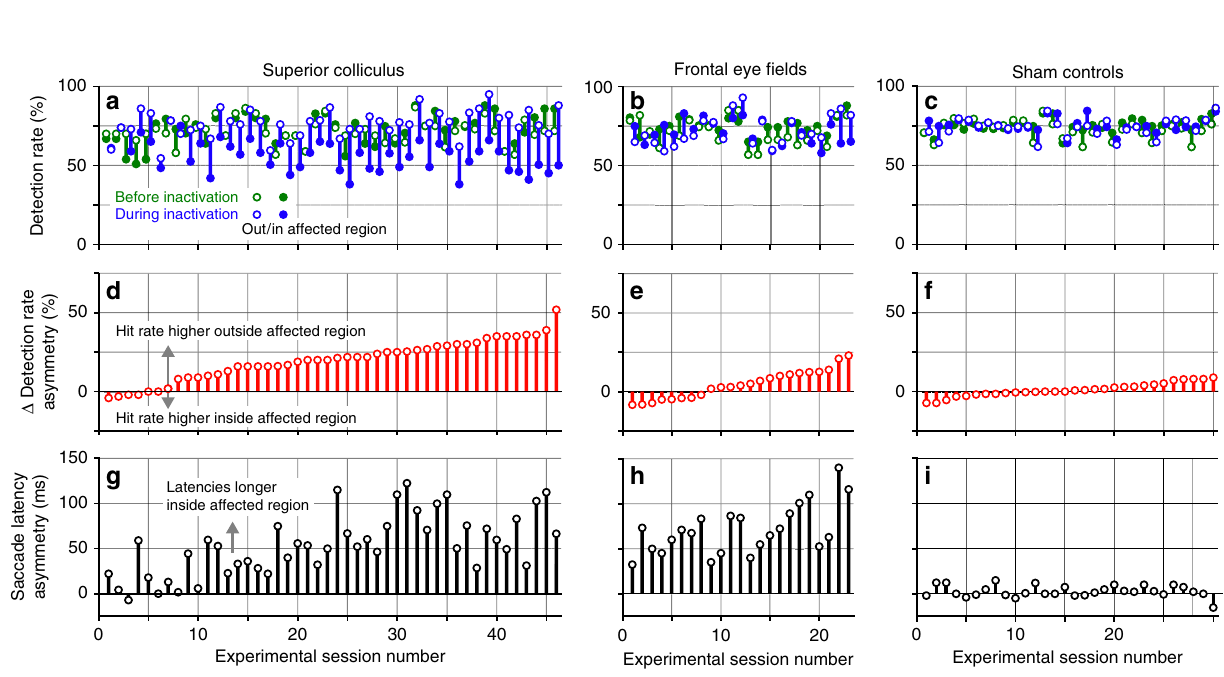
Fig. 2 Summary of FEF and SC inactivation effects on attention and saccades. a Summary of 46 muscimol inactivations of the SC, showing detection rates before (green) and during (blue) inactivation, when motion-direction changes occurred inside ( fi lled) or outside (open) the affected portion of the visual fi eld. Sessions are rank-ordered based on the size of the change in detection rate asymmetry caused by inactivation. b Summary of 23 muscimol inactivations of the FEF, using same conventions as in a . c Summary of 30 sham control experiments. d Changes in detection rate asymmetries caused by SC inactivation. Positive values indicate that, during inactivation, the difference in detection rates between the two patches became more asymmetric in favor of changes outside the affected region. e Changes in detection rate asymmetries caused by FEF inactivation. f Changes in detection rate asymmetries during sham controls. g Asymmetry in the latencies of saccades during SC inactivation observed with the visually guided saccade task. Positive values indicate that saccades made to locations on the affected side had longer latencies than saccades made toward the unaffected side. Only locations falling within the boundary of the two patches in the attention task were considered. Sessions are rank-ordered based on the data in d . h Asymmetry in the latencies of saccades during FEF inactivation. Sessions rank-ordered based on the data in e . i Asymmetry in the latencies of saccades during sham controls. Sessions rank-ordered based on the data in f . See also Supplementary Figure 2 for plots summarizing the details for each inactivation using the data